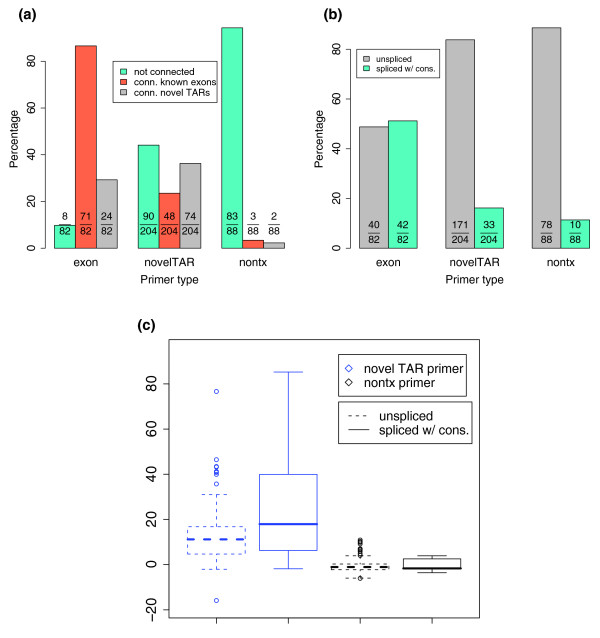
Features of the RACE products. (a) Connectivity of detected transcripts to known exons/novel transcriptionally active regions (TARs). (b) Frequency of splice and unspliced rapid amplification of cDNA ends (RACE) products derived from known exons, novel TARs, and untranscribed regions. (c) Average microarray intensities of regions encoding spliced and unspliced RACE products. nontx, region not previously shown to be transcribed.